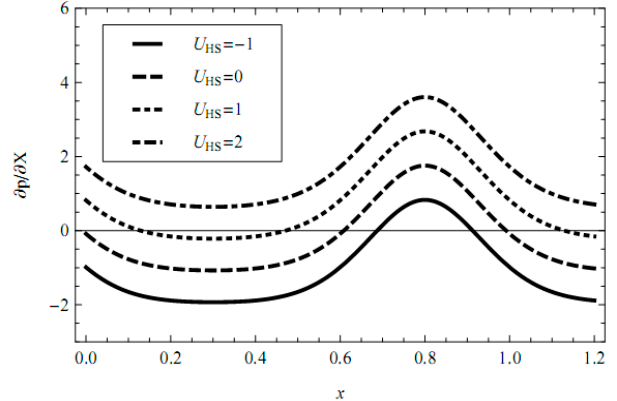
Figure 3. Profiles of the pressure gradient for various values of U HS with fixed α = 0.4, β = 0.6, λ 1 = 1, λ 2 = 1, m = 1, φ = 0.3, Q = 0.1, t = 0.8.